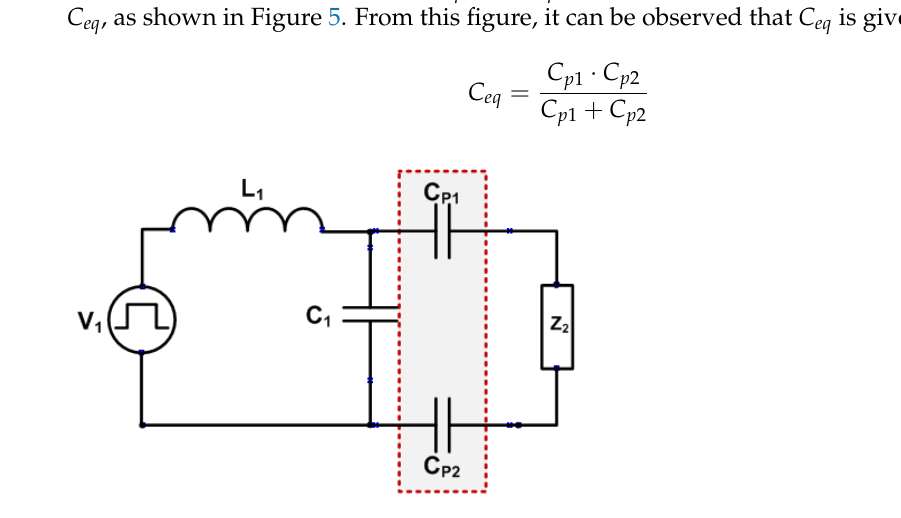
Figure 3. Z-Tank modified.